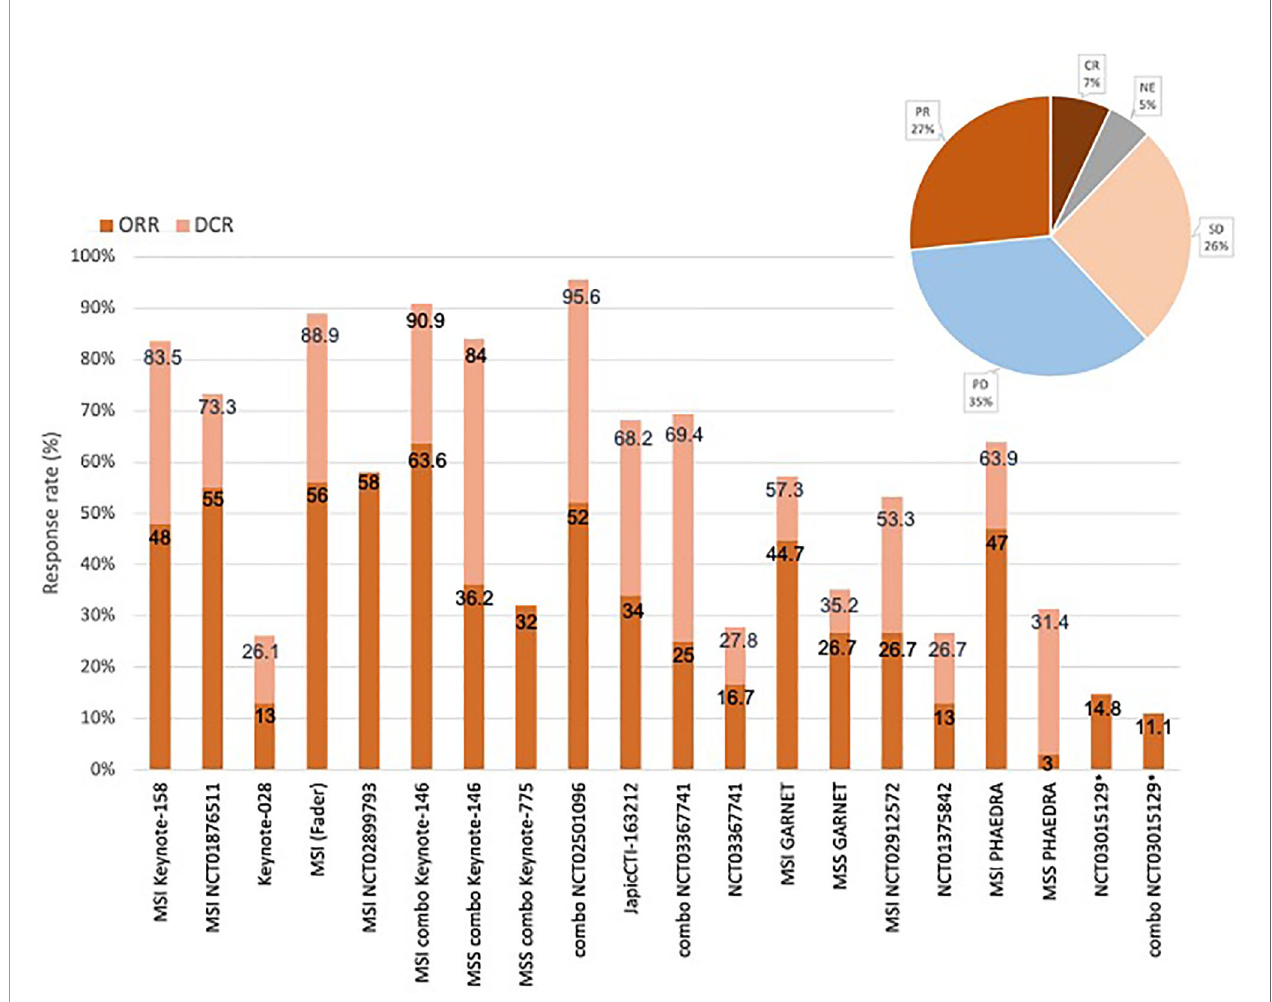
FIGURE 2 | Responses and response rates of the included studies. Overall response rate (ORR) ranged from 3% to 58%. ORR to single agents ranged from 26.7% to 58% for MSI patients, 3% to 26.7% for MSS patients (studies that selected MSI and MSS patients are indicated in the fi gure). In the combination ICIs-TKI studies ( “ combo ” in the fi gure), ORR was 32% to 52%, reaching 36.2% in MSS patients, 63.6% in MSI patients. DCR ranged from 26.1% to 95.6% in all studies, with peaks in MSI patients (around 90% as single agents or combinations) and MSS patients in case of combination (84%). Objective tumor response rate (OTRR — marked with *) to the combo durvalumab plus tremelimumab was 11.1%. Types of responses recorded in the studies were: 35% progressive disease (PD), 27% partial response (PR), 26% stable disease (SD), 7% complete response